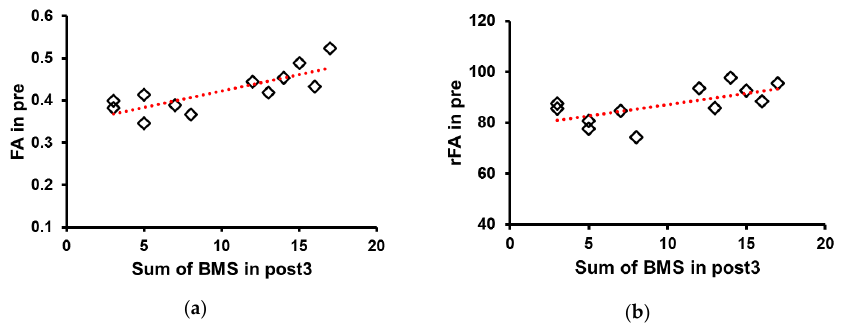
Figure 5. Correlation between fractional anisotropy (FA) value and ratio and the sum of Brunnstrom motor recovery stage ( BMS). ( a ) FA values ( R = 0.8, ** p <0.01) and ( b ) the FA ratio ( R = 0.652, * p < 0.05) at pre significantly correlated with the sum of BMS at post3. Abbreviations: baseline (pre), 3 weeks after stroke onset (post1), 3 months (post2), and 6 months (post3).